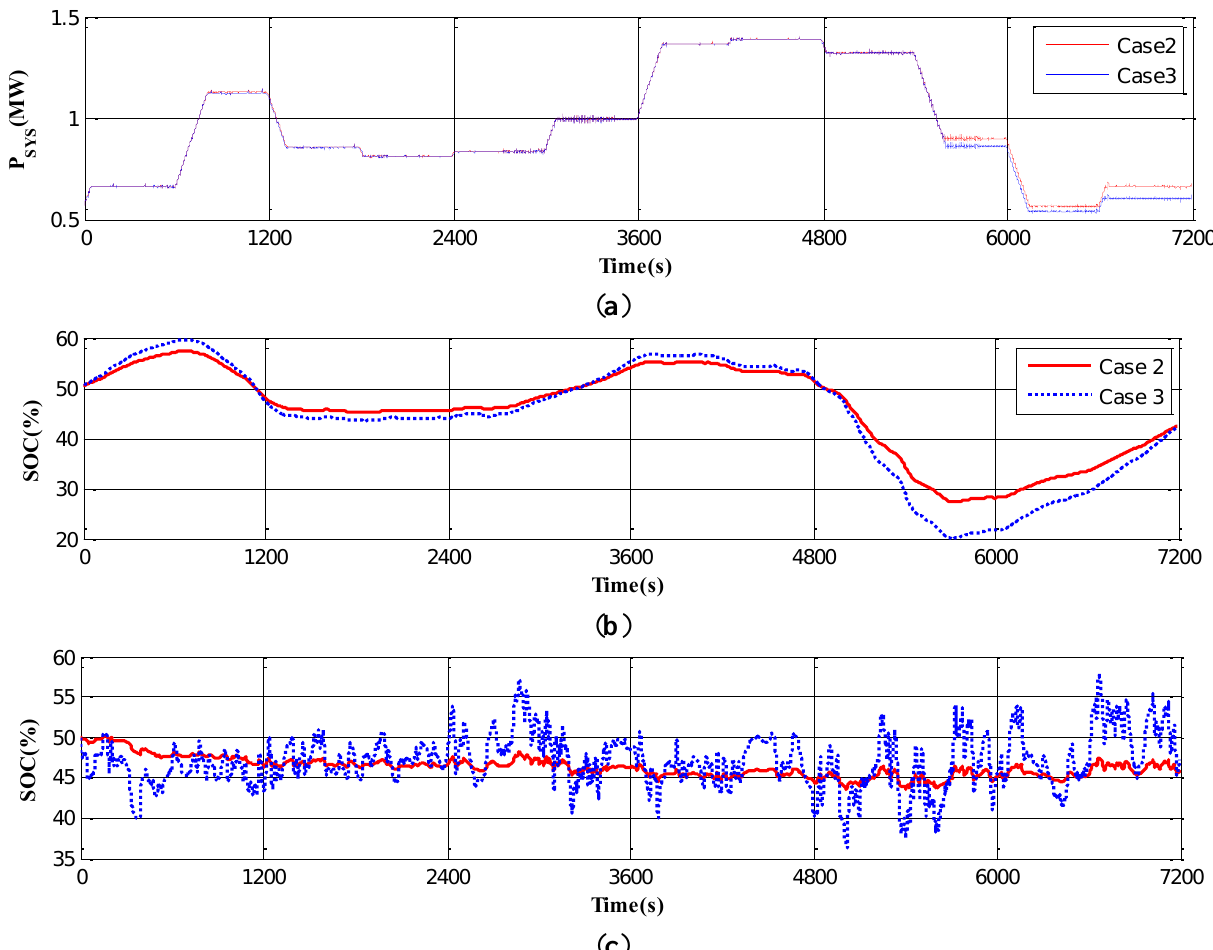
Figure 13. Comparison between the results of Cases 2 and 3 with Wind Pattern 1